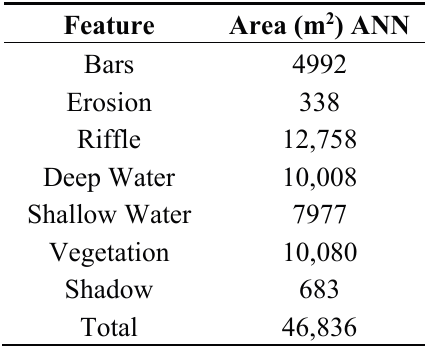
Table 5. Areas for each of the features estimated from the Artificial Neural Network (ANN)